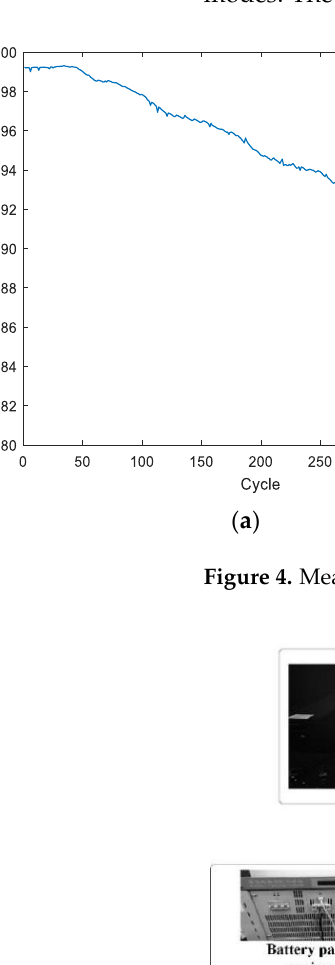
Figure 3. The flowchart of the SSA-SVM.